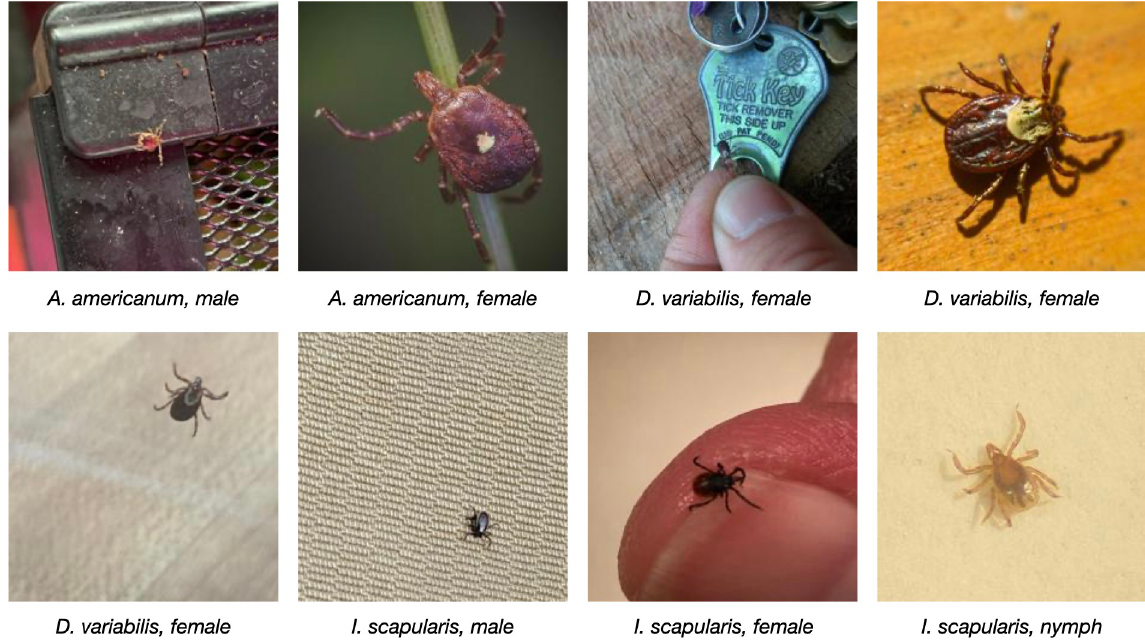
Fig 1. Representative digital images of ticks from the user-generated dataset compiled from iNaturalist, the Tick App, and the Wisconsin medical entomology laboratory. The user-generated test set includes adult, nymphal and larval, male and female, fed and unfed tick specimens of the three most common human-biting ticks in the